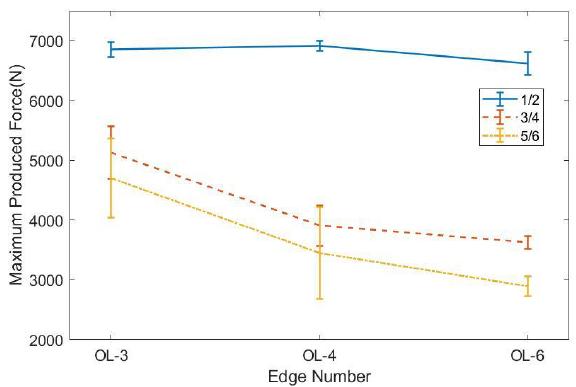
Figure 14. The experiment maximum impact forces. Table 4. The maximum impact forces produced by the panels.